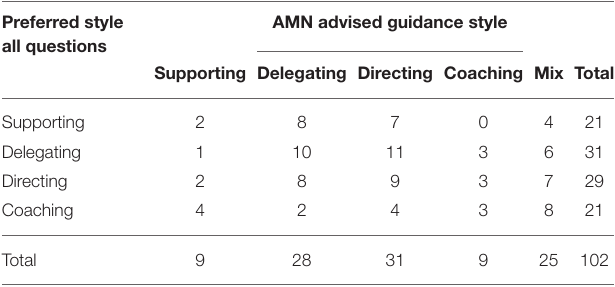
TABLE 2 | Students of cohort 2016–2017, which formed the basis of this study. TABLE 4 | Cross tabulation of the guidance style advised by the AMN, and the preferred guidance style as deduced from the student’s answers to all questions about behavior aspects of the